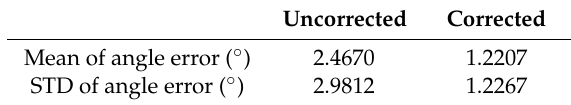
Table 3. Test Occasion 2: Mean and STD of the heading angle error under small interference.